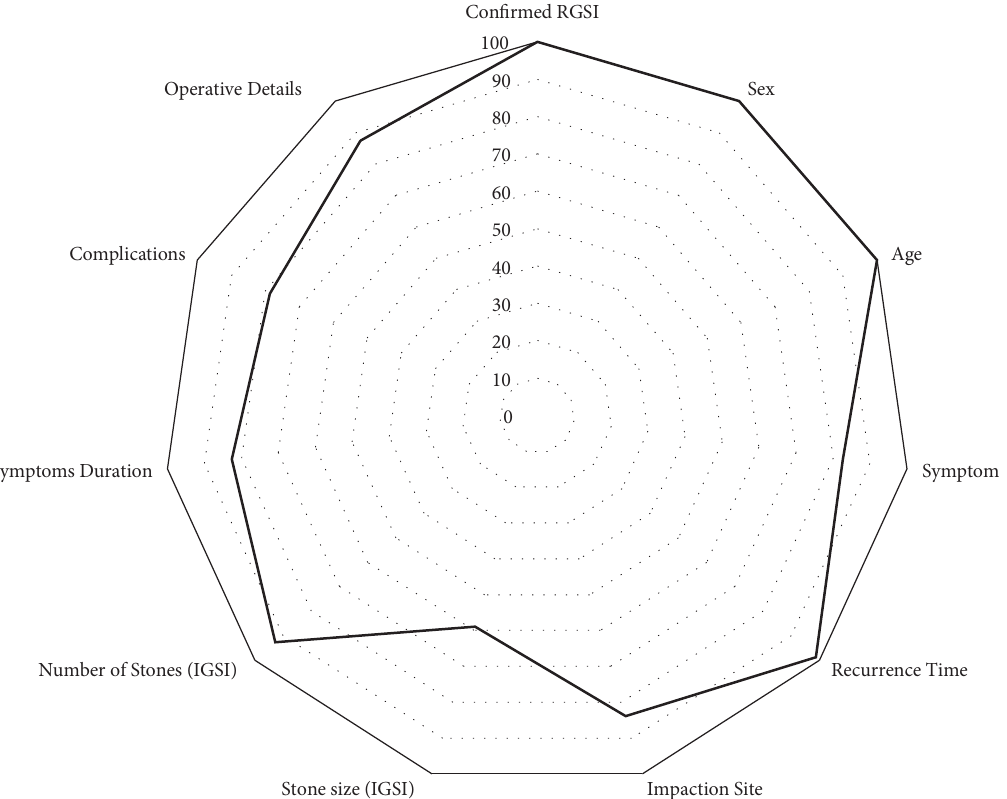
Figure 2: Completeness of data